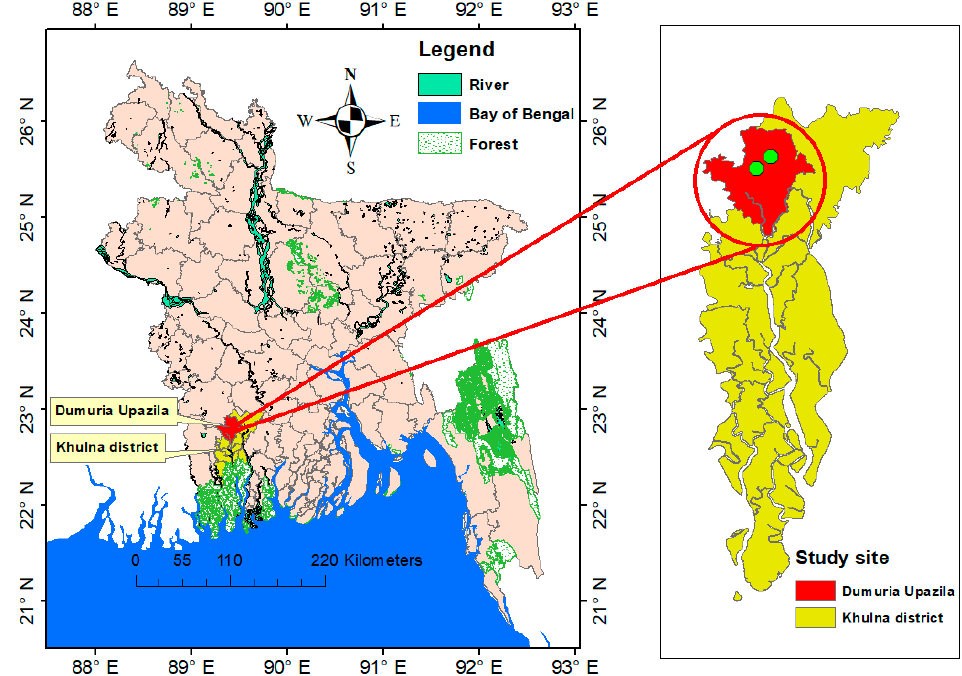
Figure 1. Map of Bangladesh showing the study sites at Dumuria Upazila in Khulna district. Scale applies to the map of Bangladesh only. Table 1. Characteristics of study sites.